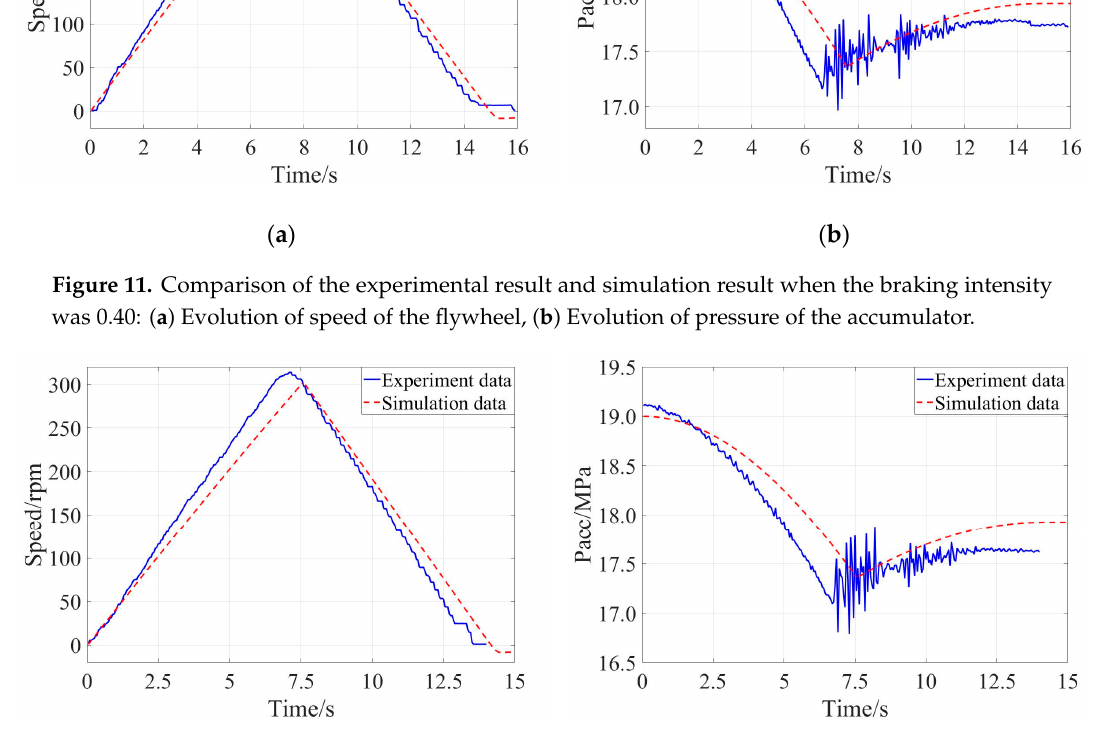
Figure 12. Comparison of the experimental result and simulation result when the braking intensity